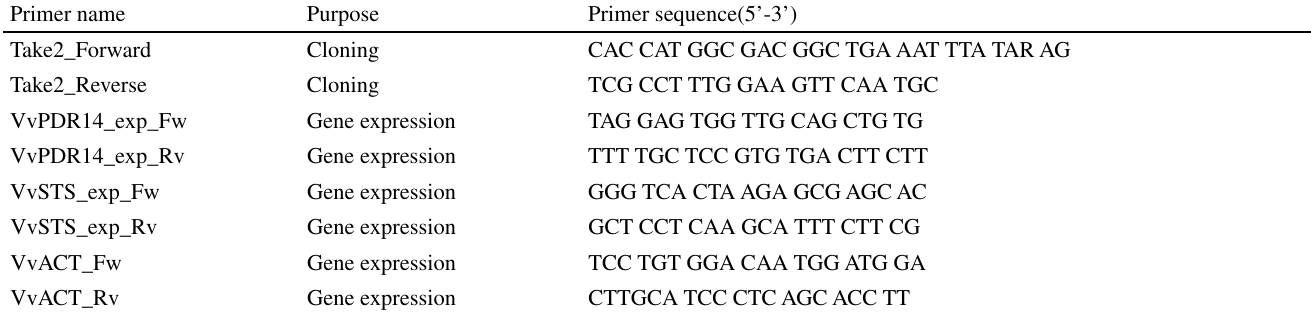
Table 1 - Primers used in this study